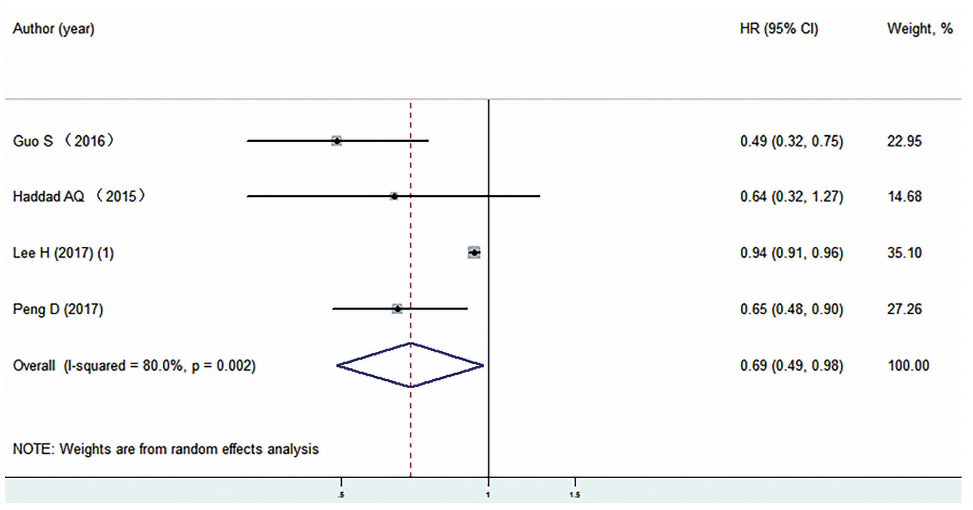
Figure 4 - Preoperative serum TC levels and PFS in patients with surgically treated